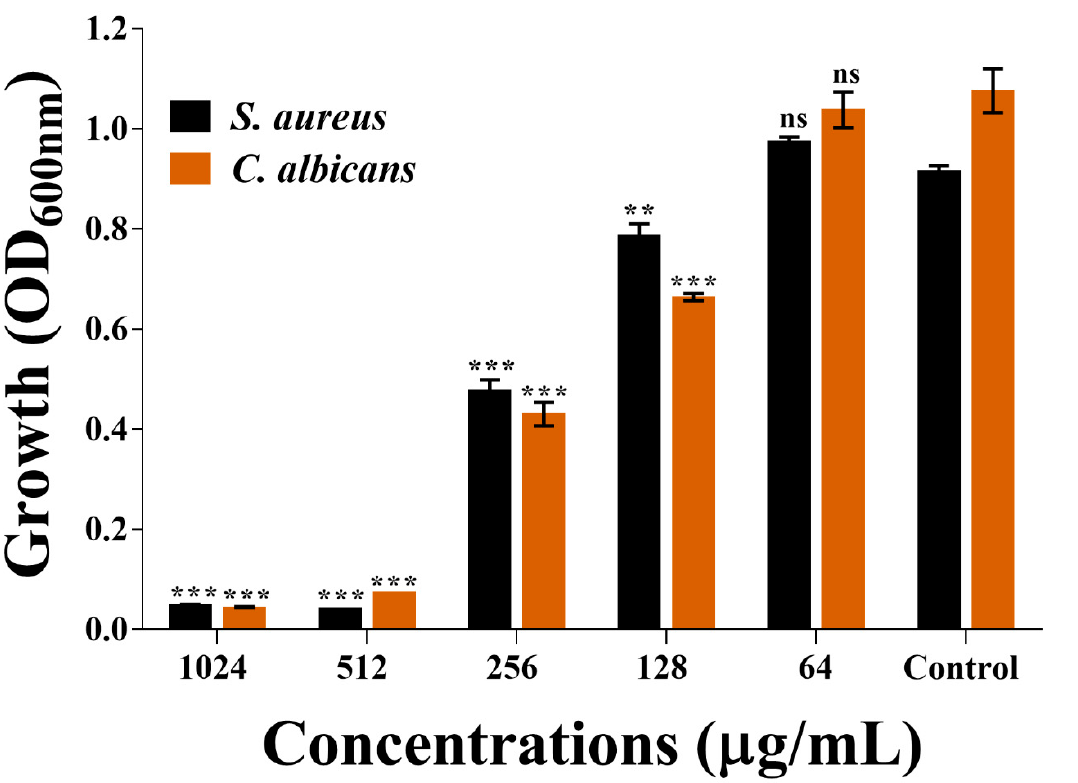
Figure 5. Growth study for determining the MIC values of β -c-AuNPs against S. aureus and C. albicans . *** p < 0.0001 and ** p < 0.01 are statistically significant compared to the control, whereas ns is non-significant.